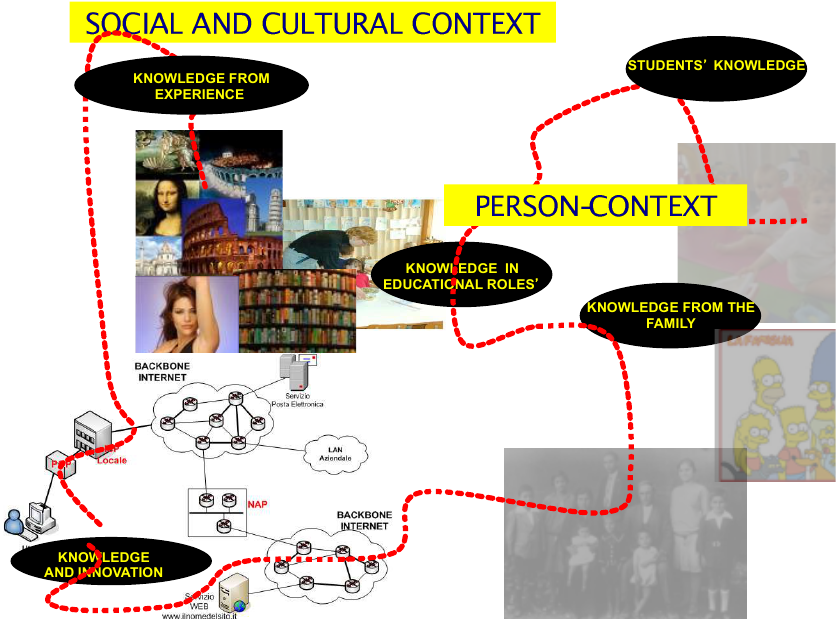
Figure 1: The learning relationship is a contract between the individual and one’s own private, professional, social roles in the interaction between the inner context-Person and the outer context- Social and Cultural